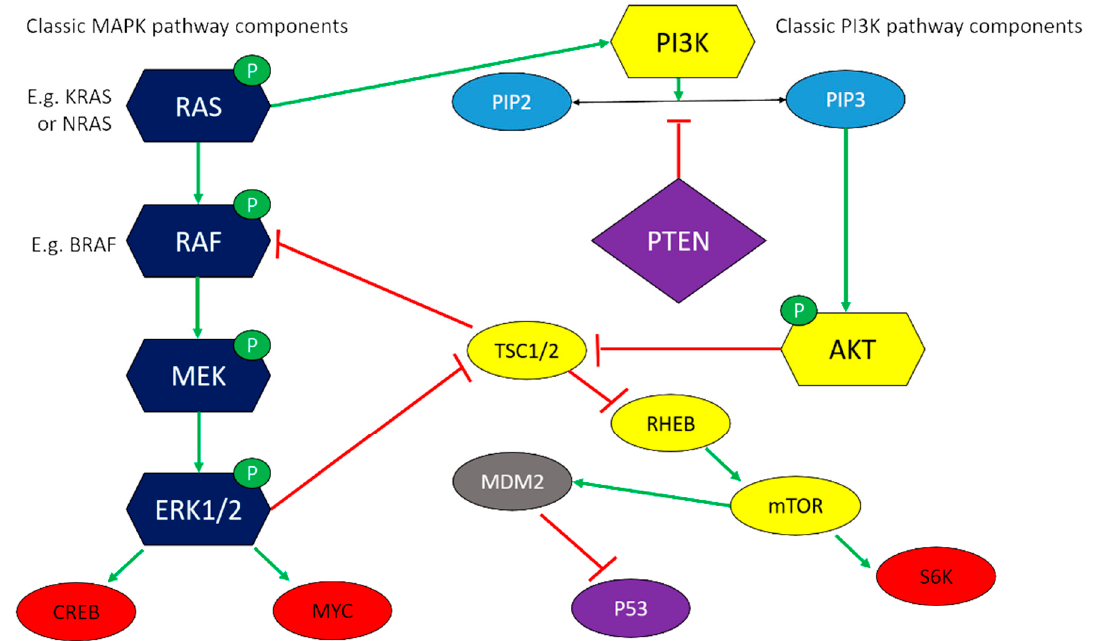
Figure 1. Key components of the MAPK and PI3K signalling paths featured in this review. Classical MAPK and PI3K components are shown in navy and yellow shapes, respectively. Green arrows indicate activating effects; red bars indicate inhibitory effects. Red shapes illustrate key transcription factors driving cell proliferation, growth, and survival, whereas purple shapes indicate key tumour suppressor proteins.